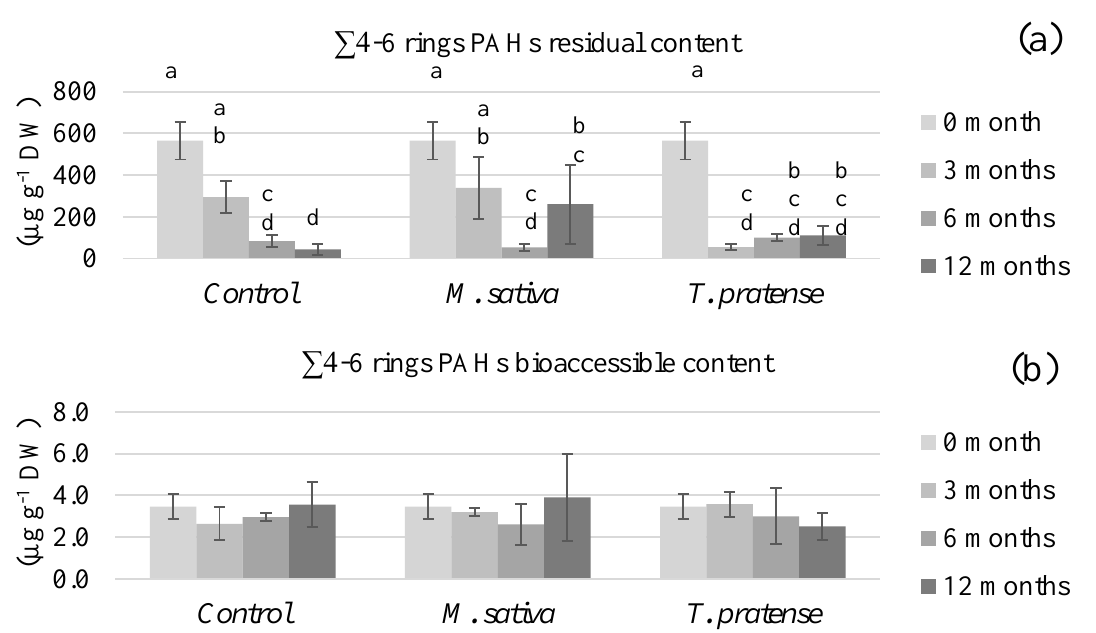
Figure 5. The heavy PAHs’ (∑4–6 rings) ( a ) residual and ( b ) bioaccessible of soils planted with M. sativa L. or T. pratense L. compared to unplanted control samples after different time periods. The values are means ± confidence interval (α = 5%, n = 5). There is a significant interaction between the type and the time of culture, so within each PAH fraction (residual or bioaccessible) sticks that share the same letter are not significantly different ( p > 0.05).